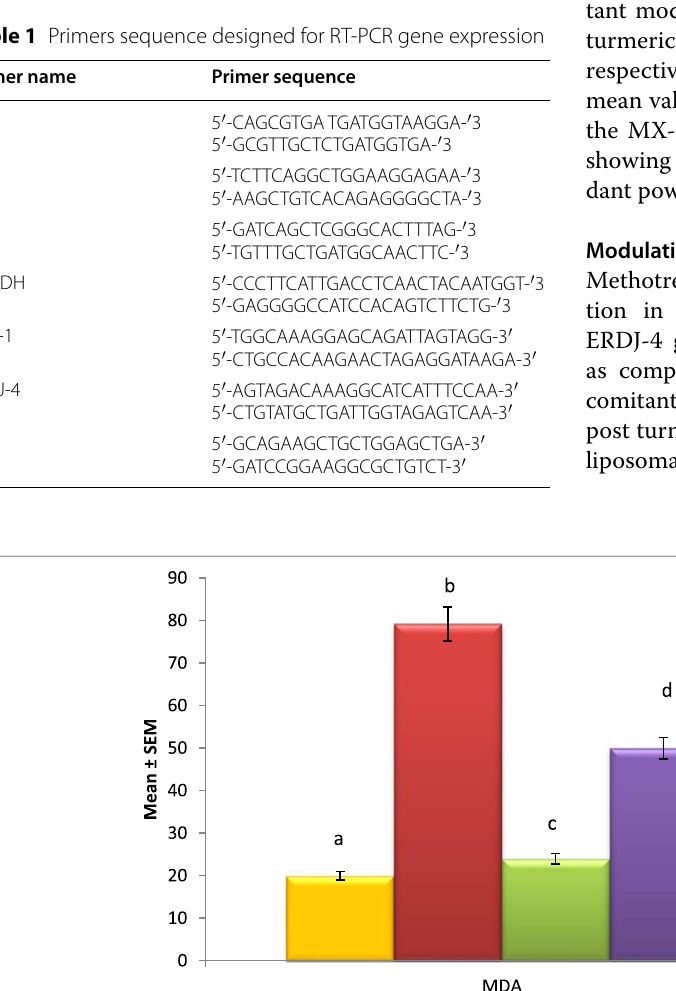
Fig. 1 Impact of turmeric and liposomal turmeric on serum malondialdehyde level post methotrexate intoxication. Data are expressed as mean SEM ( n 10). p 0.05 value is considered significant. Groups having the same letter are not significantly different from each other, while those ± = ≤ having different letters are significantly different from each